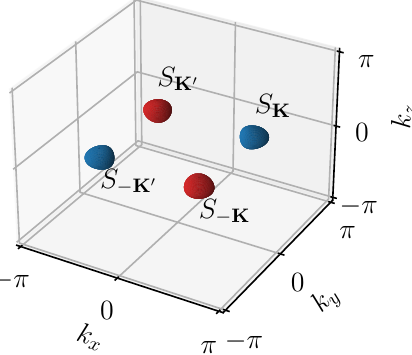
Figure 2: The position of the four ellipsoidal Fermi surfaces in the Brilliouin zone. The color of a Fermi surface denotes the chirality of the Weyl point it encloses with red (resp. blue ) with C = 1 (resp. −